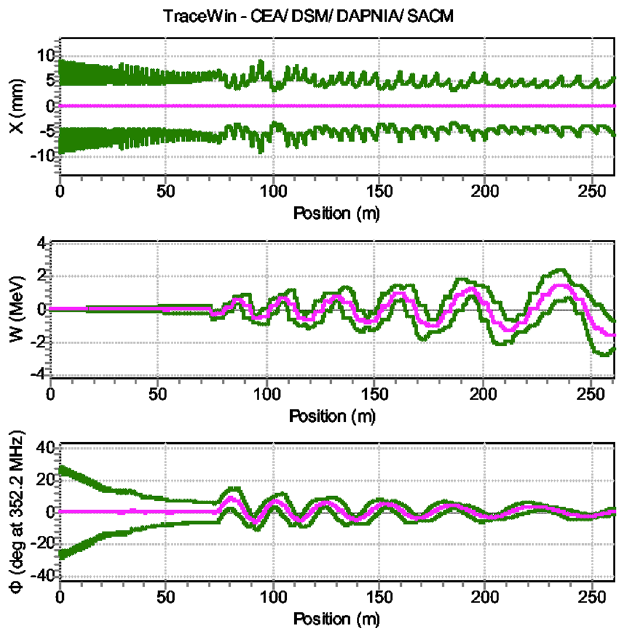
FIG. 9. Envelopes at 100 (cid:4) s .